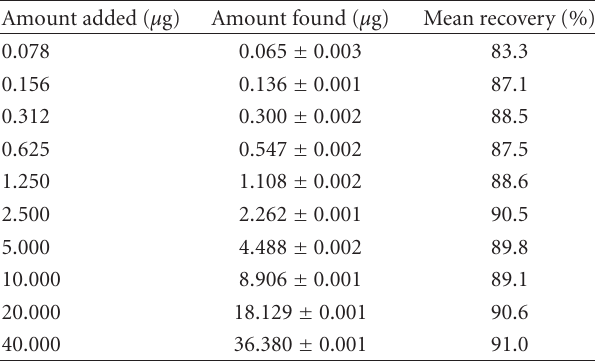
Table 1: Results of a recovery study of APAP-Cys from spiked a rat liver matrix protein dispersion a,b